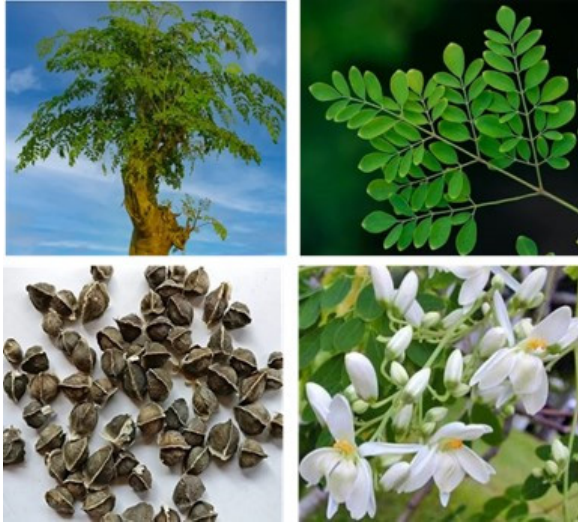
Figure 1. Images of M. oleifera tree, leaves, seeds, and flowers. The feathery leaves of the tripinnate complex have green curved leaflets that are nous plant. The alternate twice or thrice pinnate leaves appear at the branch tips in most cases. They have a long petiole with 8–10 pairs of pinnae, each bearing two sets of inverse elliptic leaflets and one at the apex and are 20–70 cm long when young